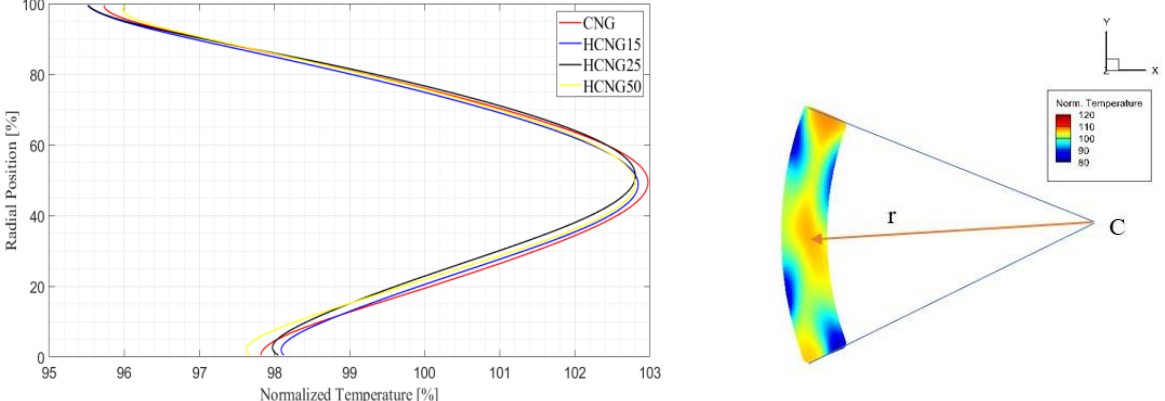
Figure 16. Tangentially-averaged TIT values against radial position ( left ), and temperature contour in the TP outlet section ( right ).